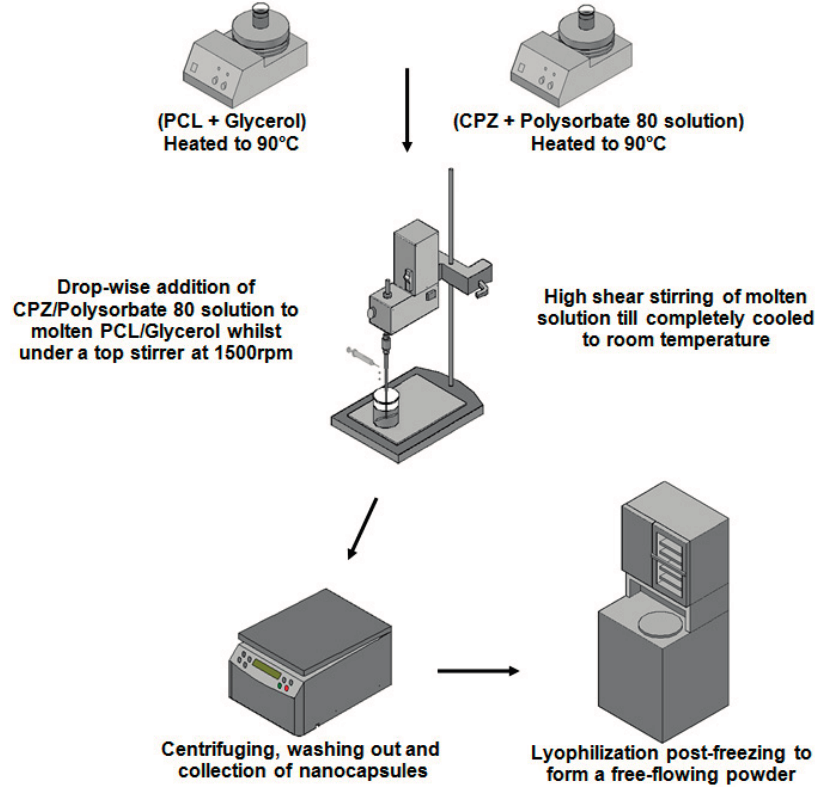
Figure 1. Schematic depicting the synthesis process of the chlorpromazine hydrochloride (CPZ)-loaded, poly- ε -caprolactone (PCL) based nanocapsules by the novel melt-dispersion